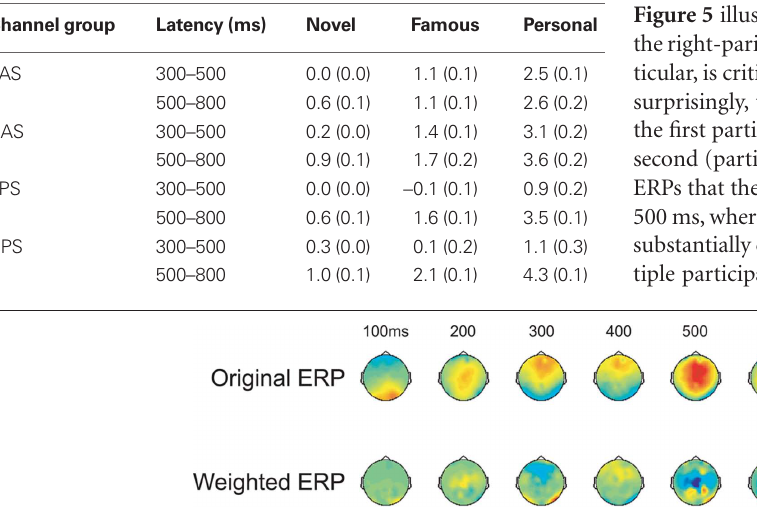
Figure 3 | Topographic maps of the evoked response. Upper column: grand-averaged ERP for personal (faces of friends and family) stimulus class. Lower column: same grand-averaged ERP weighted by the general classifier model (linear discriminant